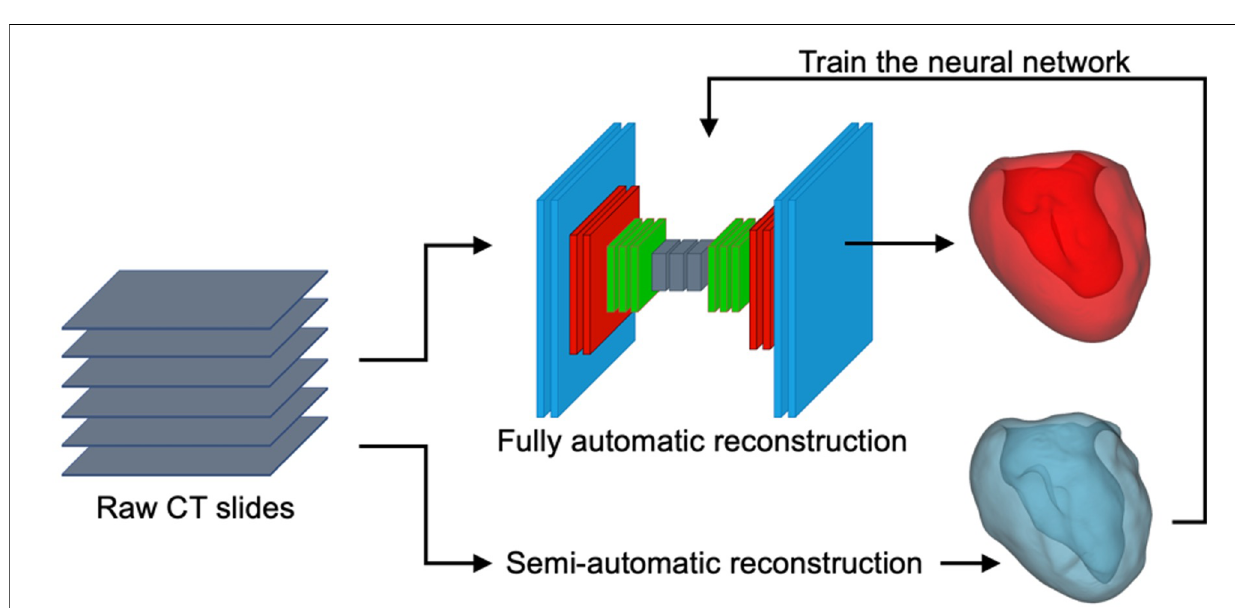
FIGURE 2 Schematic representation of the U-Net neural network, semi-automatic segmentation of the LV using 3D-Slicer (blue), and a sample AI-predicted reconstructed LV geometry